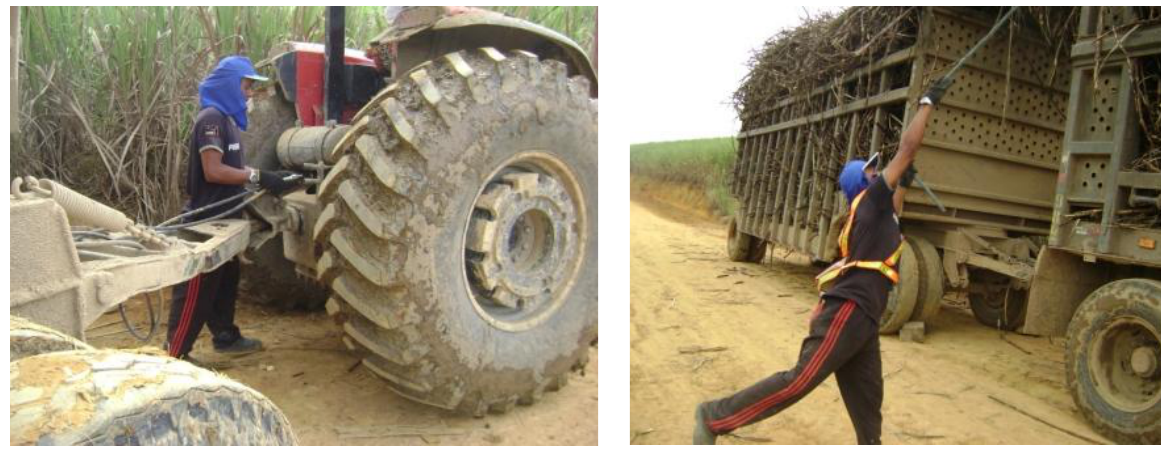
Figure 1. Unhooking sugarcane trailers from the truck to tractors (working activity 1)